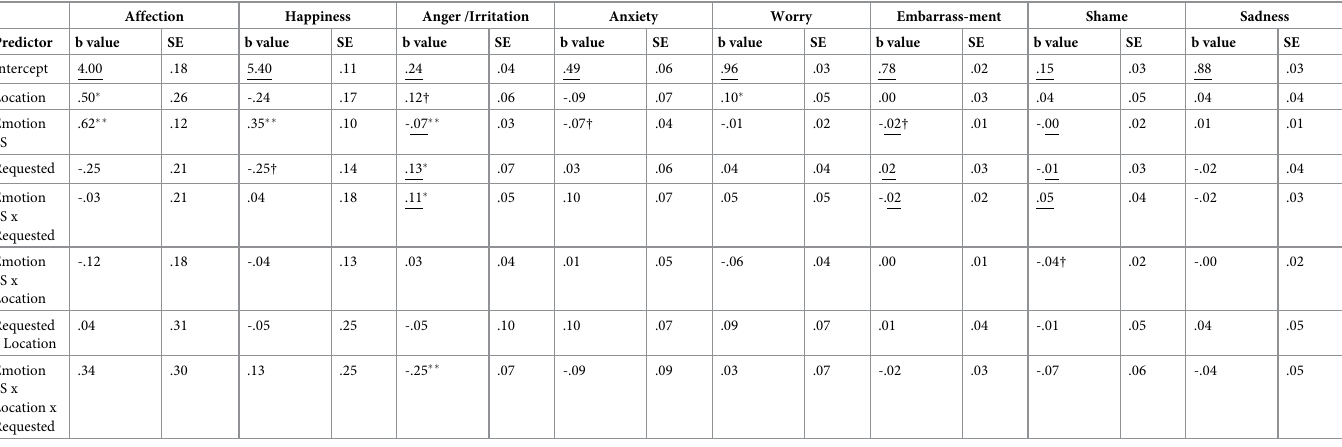
Table 2. Culture and emotional correlates of emotional social support provision. Affection